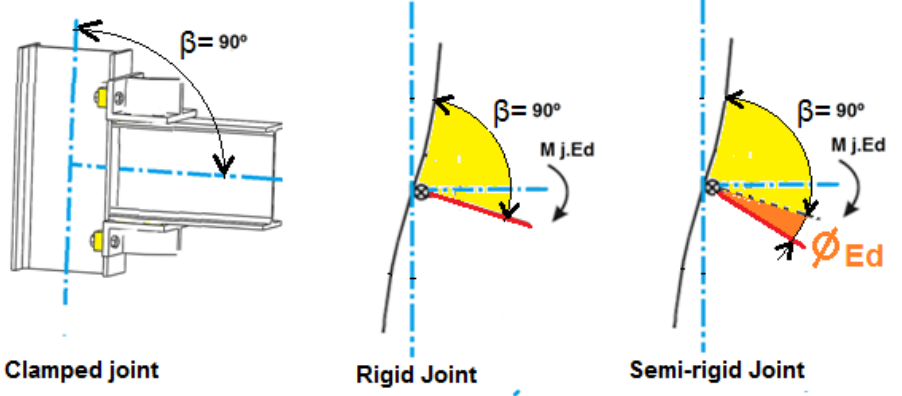
Figure 3. Example of rotation of a joint with initial relative angle ( β ) of 90 ◦ between the profiles for rigid and semi-rigid joint.